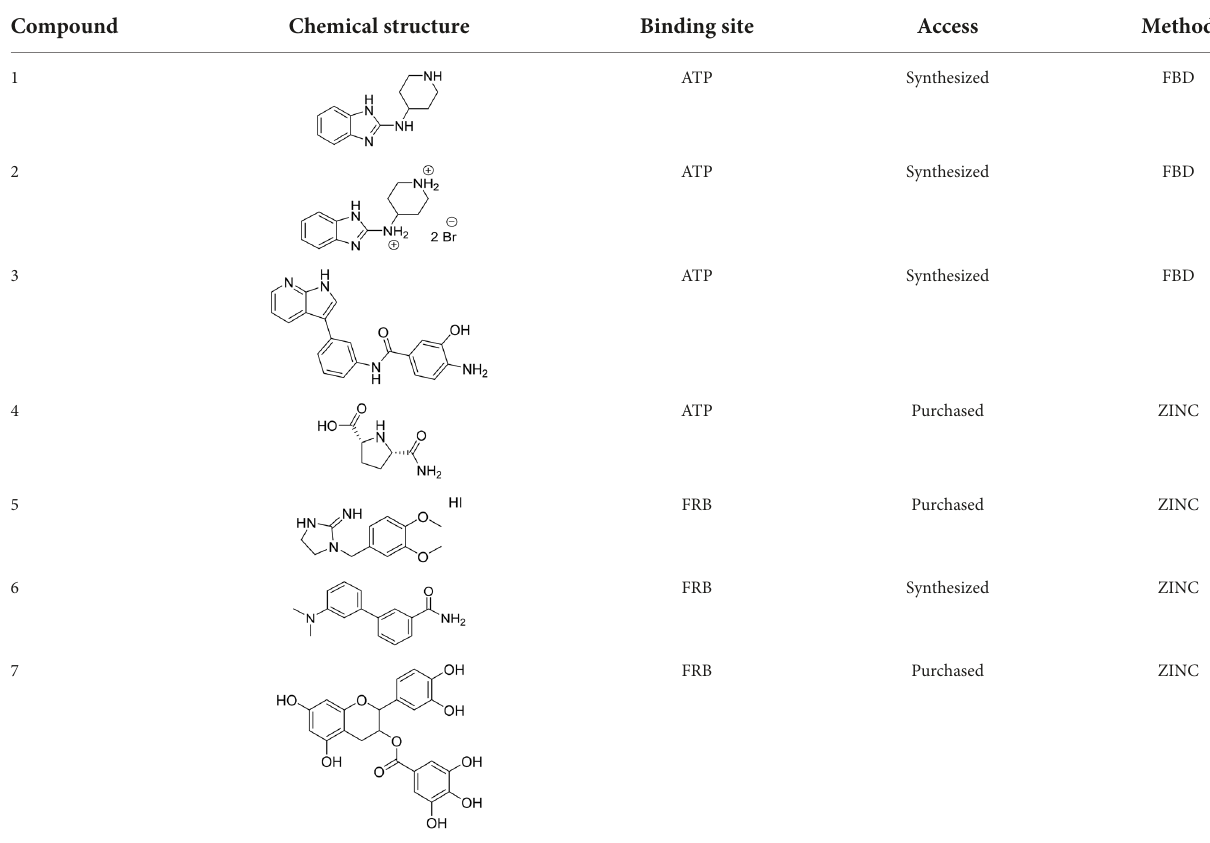
TABLE 1 List of selected lead compounds that were forwarded for further